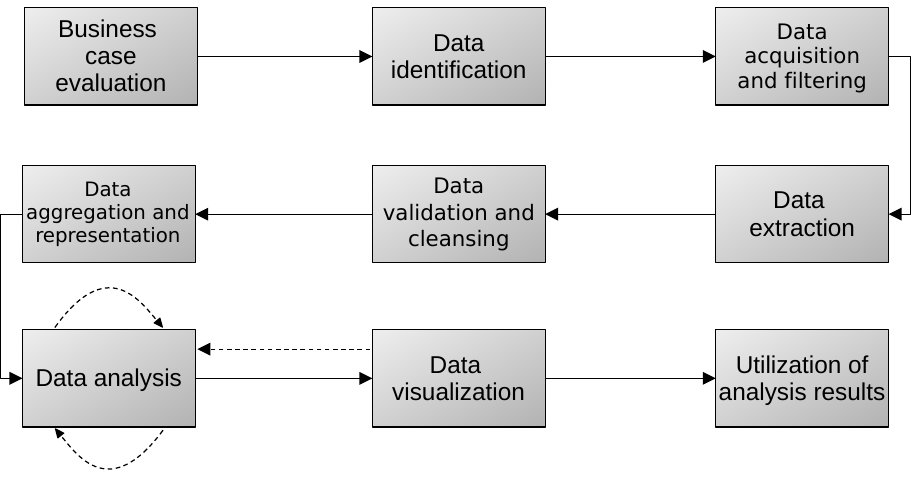
Figure 10. Big Data lifecycle [16].